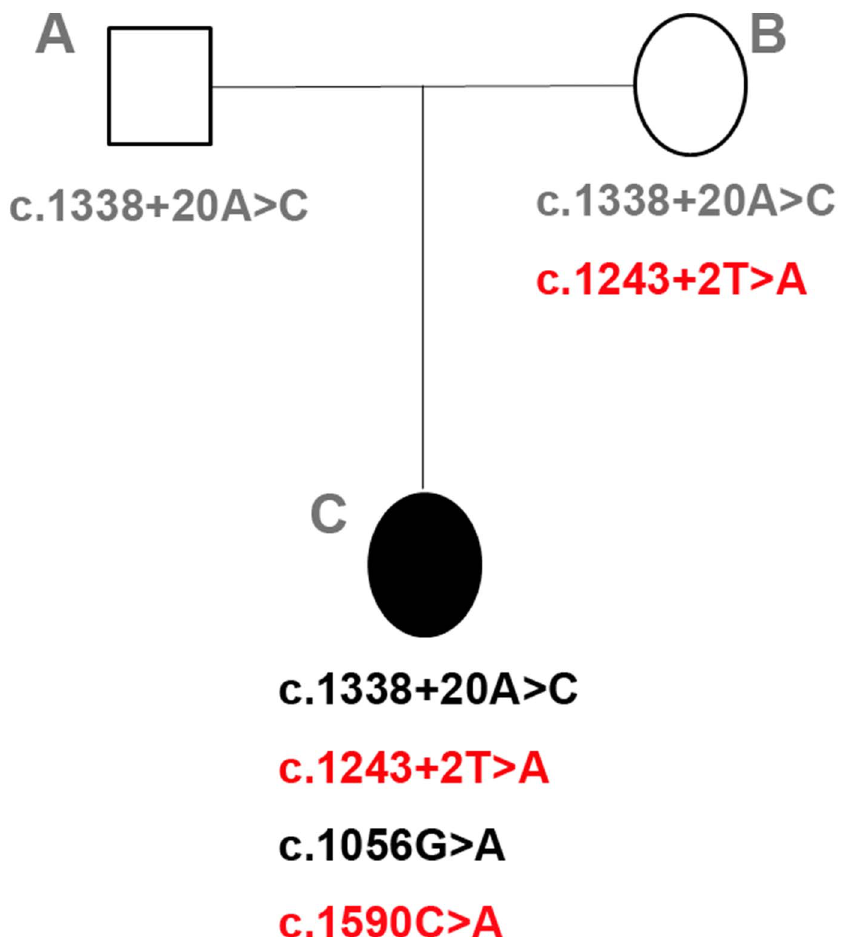
Figure 4. Pedigree of the Chinese family and mutations of RPE65 gene. In the family structure, male and female are represented by squares and circles, respectively. The filled square symbol represents the ESORD-affected daughter (c). One mutation (c.1338 + 20A . C) is detected in RPE65 gene of her father (a); two other mutations (c.1243 + 2T . A and c.1590C . A) are detected in her mother (b); four mutation are found in the daughter (a). The red color highlights the novel mutation.